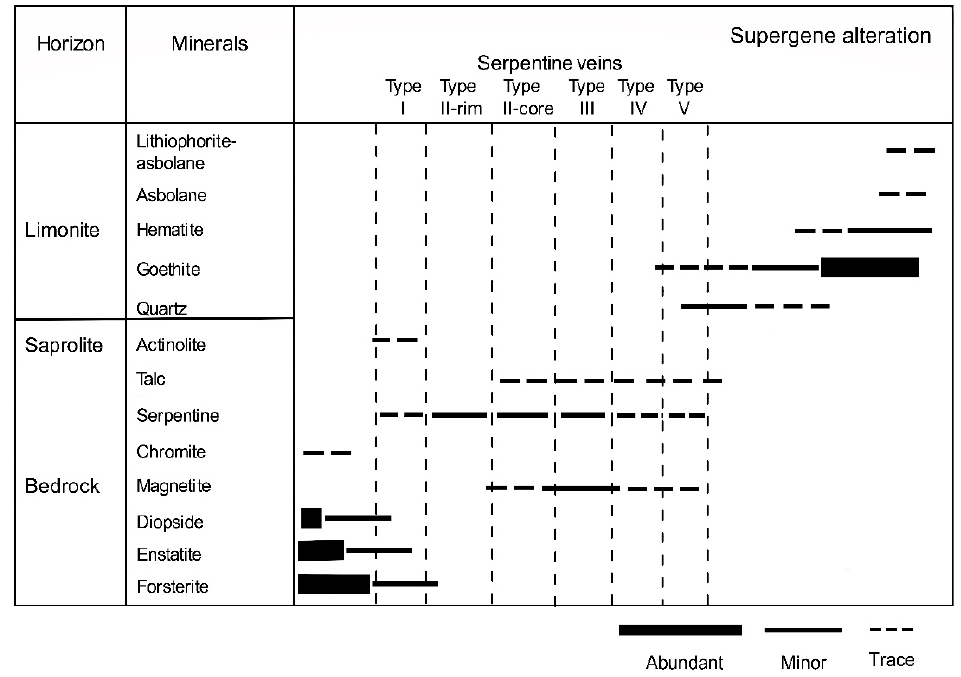
Figure 18. Mineral paragenesis and abundance of primary and alteration minerals with Ni-bearing serpentine veins in the bedrock and saprock of the Intex laterite deposit in Mindoro, Philippines.